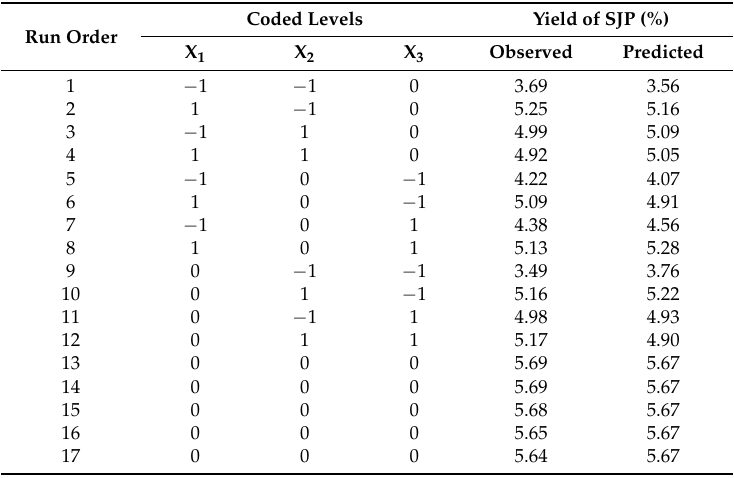
Table 1. The BBD matrix and response values for the extraction yield of